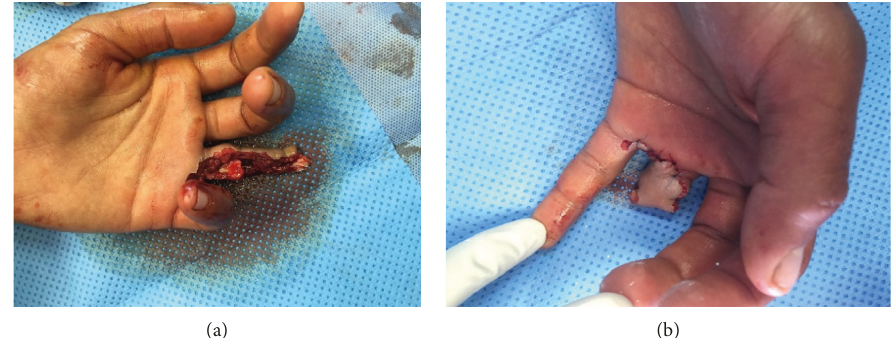
Figure 2: (a) Clinical aspect after debridement and regularization at the level of traumatic amputation. (b) Coverage of the bone by the radial flap using separated